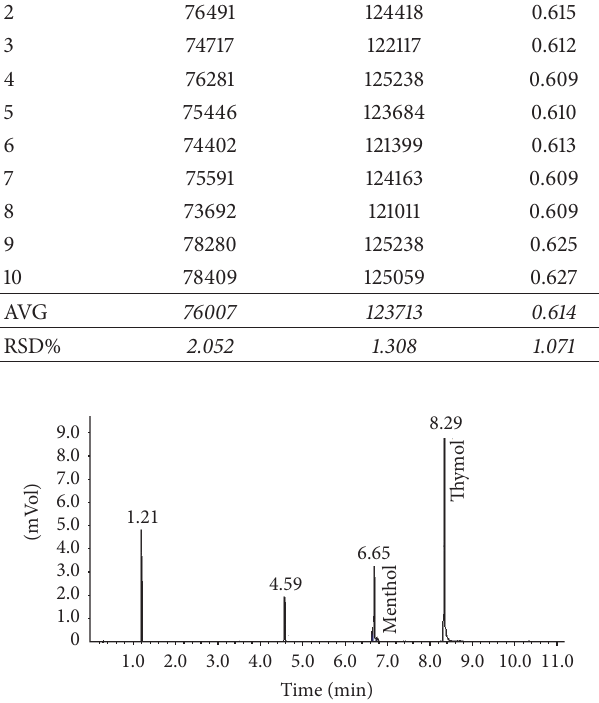
Figure 2: GC chromatogram of menthol and internal standard